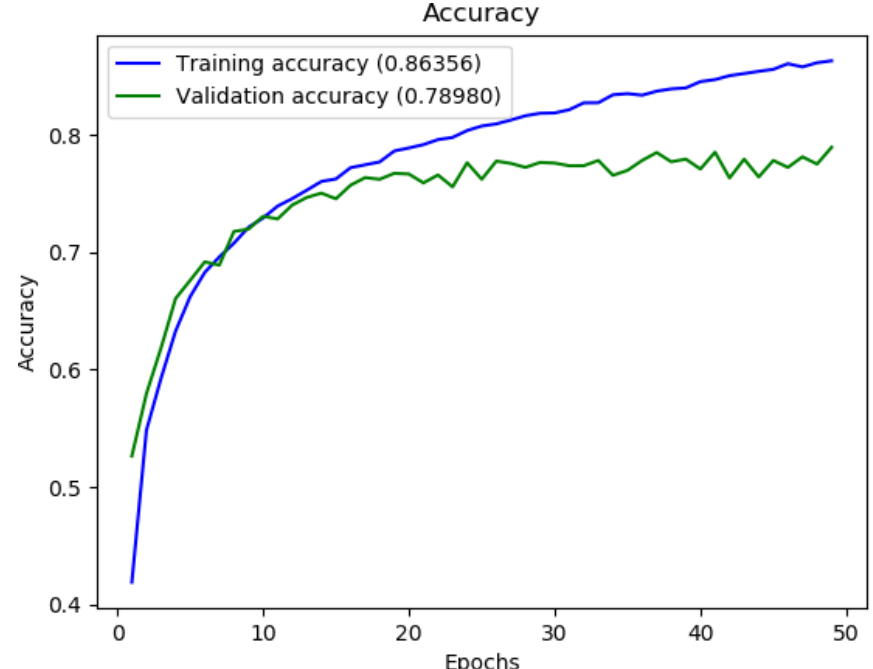
Figure 4. Accuracy graph of the network in [21], trained with the FER2013 database with the FER+ annotations using the data augmentation and the z-score normalization. Figure from [35].